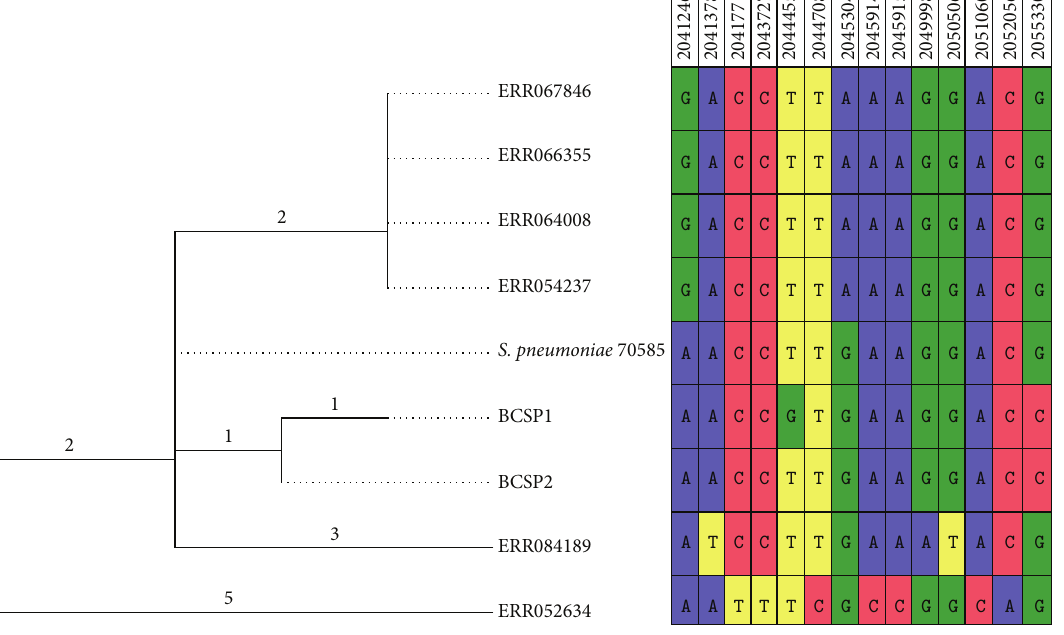
Figure2:Neighborjoiningtreeofsinglenucleotidevariants(SNVs)withinthegenomicislandshowingtheevolutionaryrelationshipbetween BCSP1 and BCSP2 (sequenced as part of this study), the 70585 reference, and six strains sequenced by Chewapreecha et al. [16] (ERR067846, ERR066355, ERR064008, ERR054237, ERR084189, and ERR052634). The table to the right shows the individual SNVs that separate the isolates, with their position in the 70585 reference at the